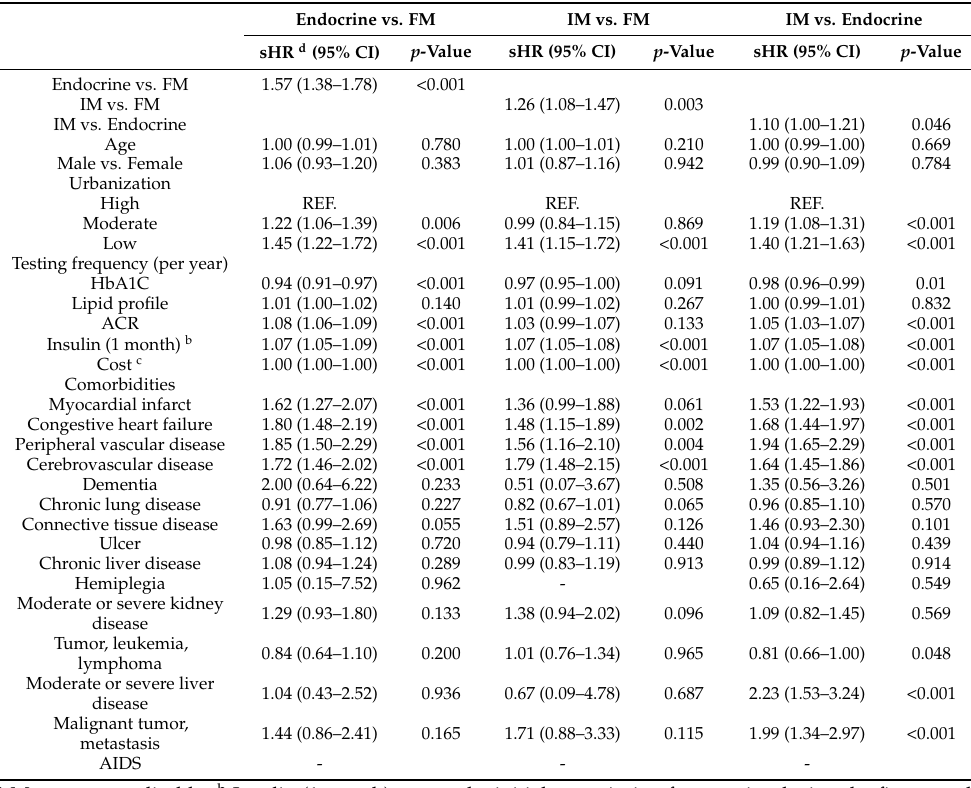
Table 4. Prediction of the occurrence of acute complications a